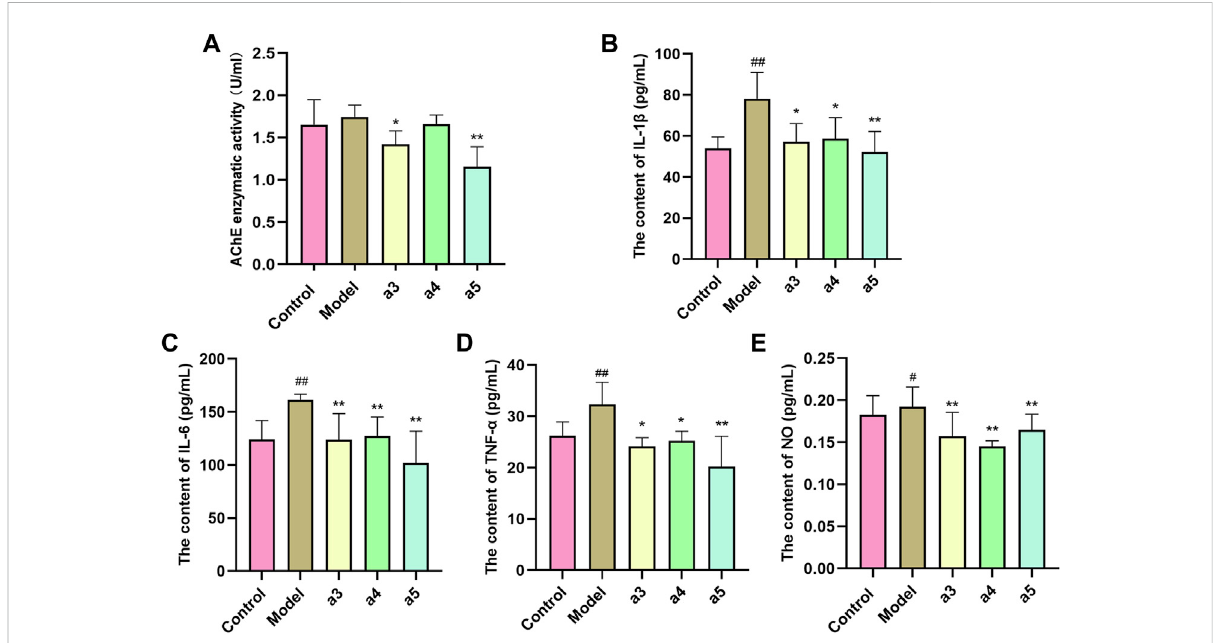
FIGURE 10 In vivo validation of 3 key active ingredients. (A) Inhibitory effects of 3 key active ingredients on AChE in the hippocampus of APP/PS1 mice. Effect of 3 key active ingredients on the production of IL-1 β (B) , IL-6 (C) , TNF- ɑ (D) , and NO (E) in the hippocampus of APP/PS1 mice. The results represent the mean ± SEM ( n = 6), vs. Normal blank ## p < 0.01; vs. Model * p < 0.05, ** p <